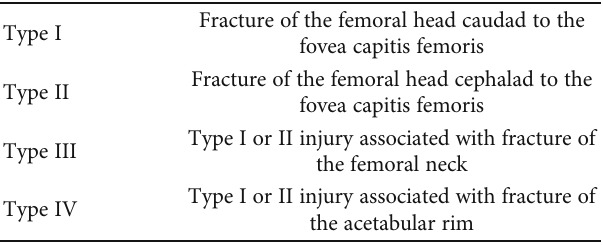
Table 1: Pipkin classi fi cation of femoral head